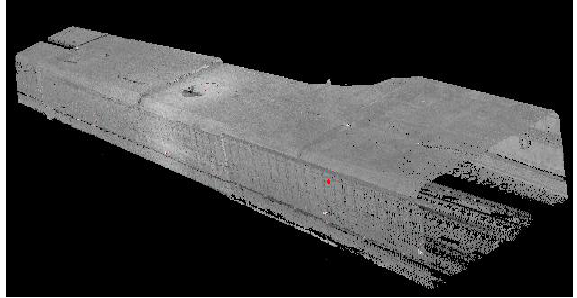
Figure 2. Original point cloud data